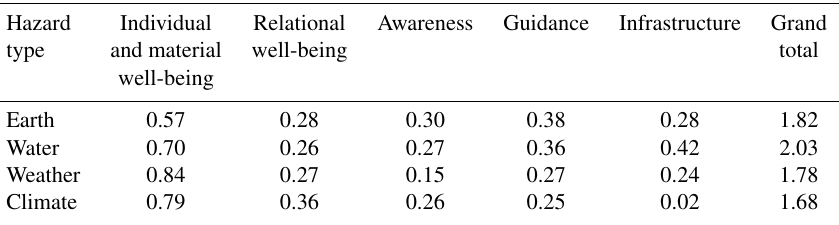
Table 4. Fraction of all communities for each hazard type, which have used responses from any of the five response classes. Totals exceed 1.00 because communities use responses from more than one class.